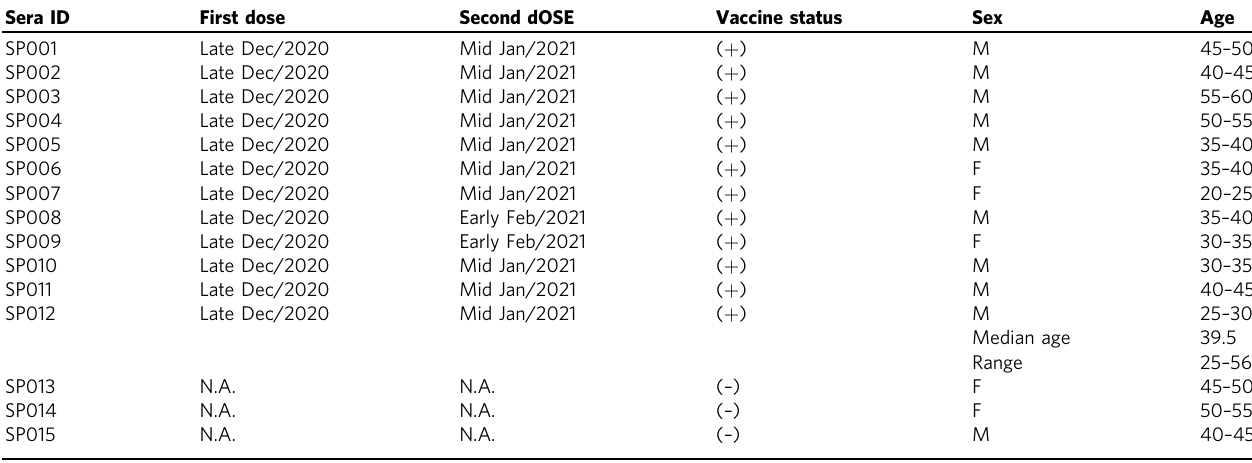
Table 1 Cohort characteristics of Sputnik vaccine recipients from ANLIS MALBRÁN (Buenos Aires, República Argentina). Sera